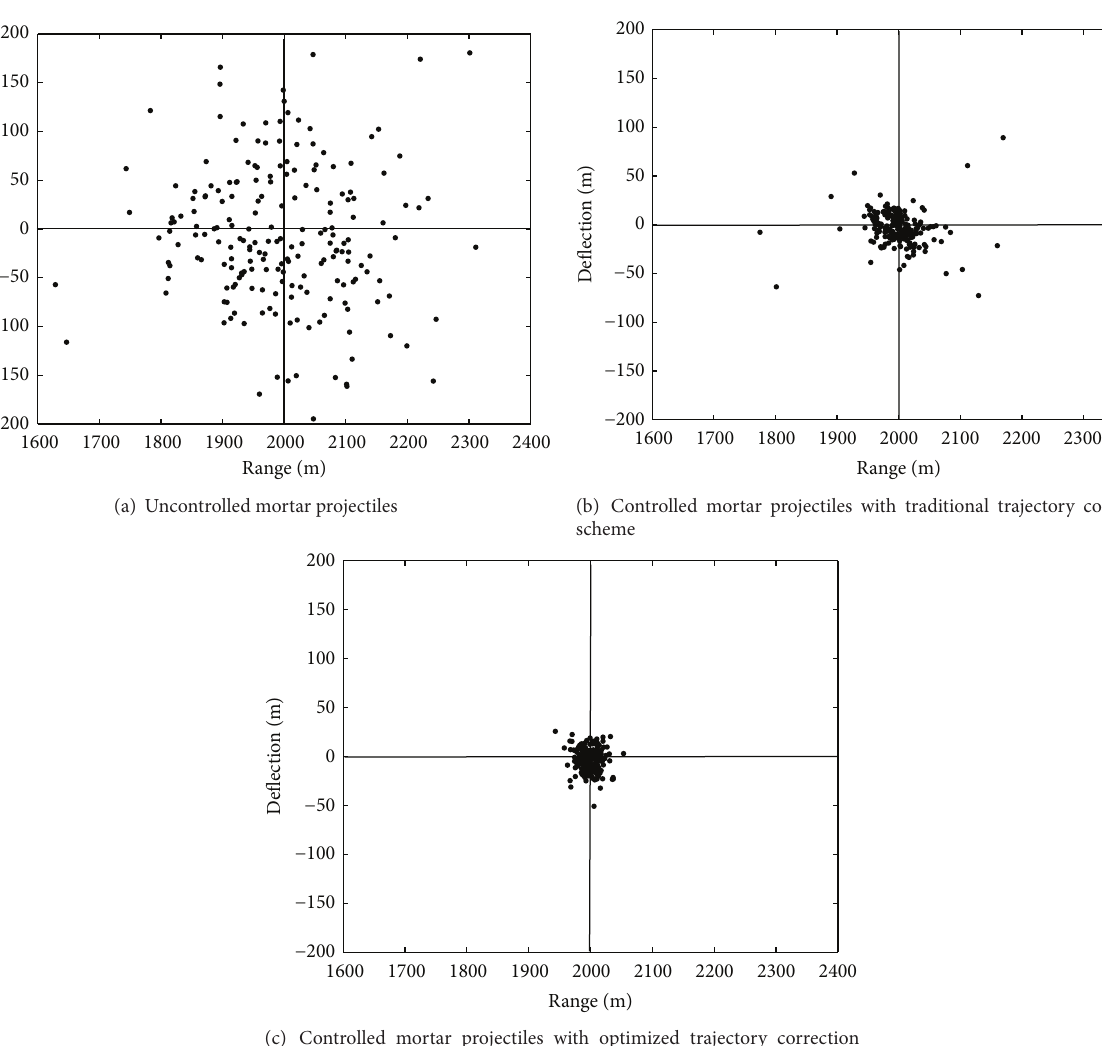
Figure 24: Impact point